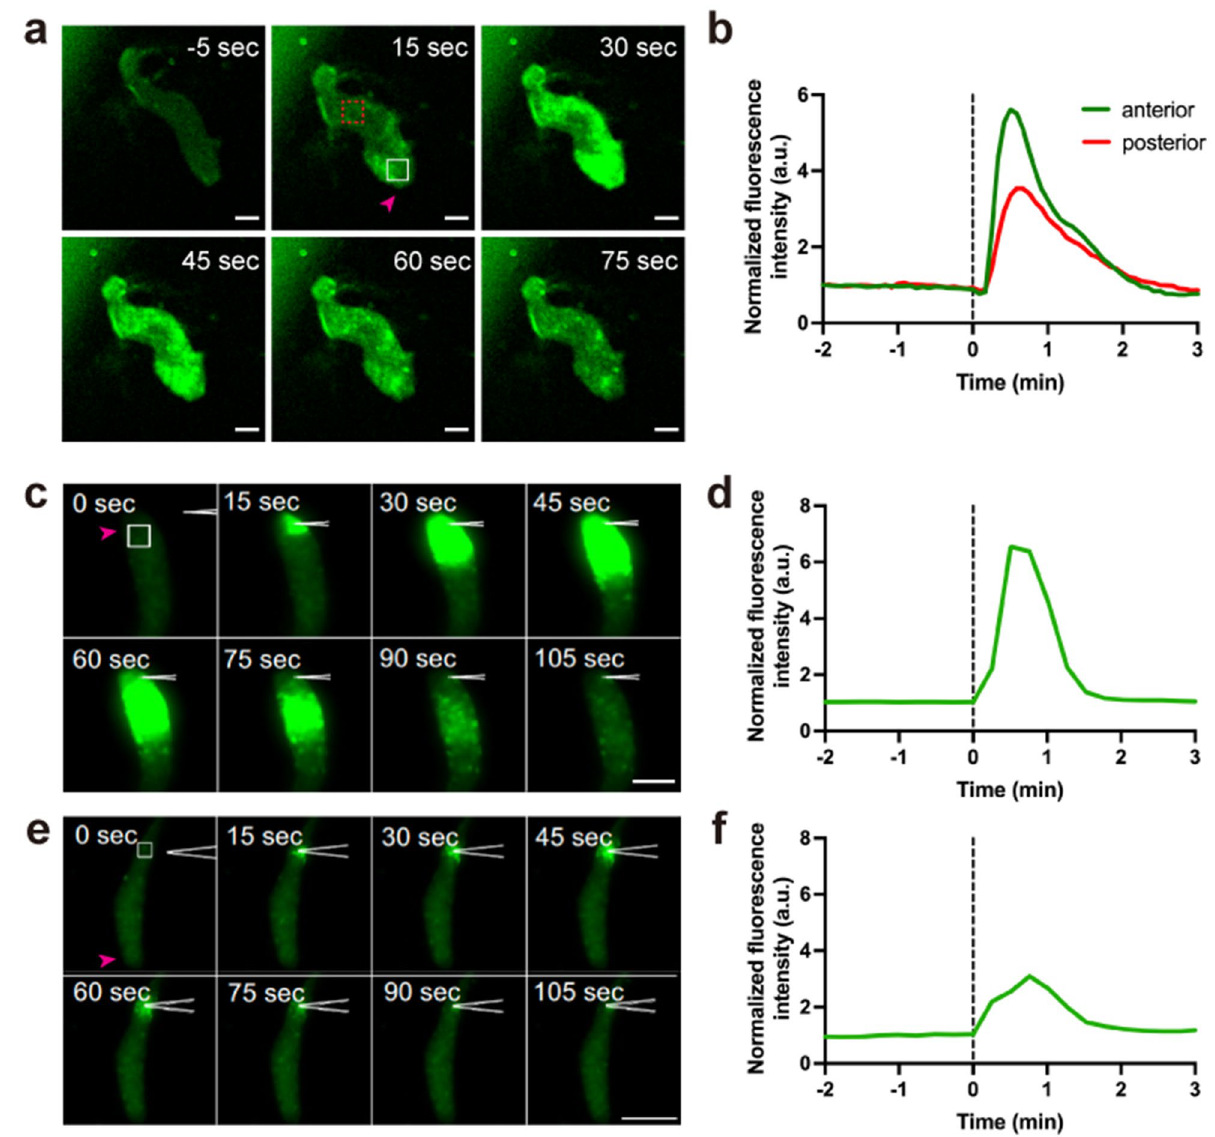
Figure 3. Intracellular Ca 2+ ([Ca 2+ ] i ) bursts in Dictyostelium slugs induced by mechanical stimulation. ( a ) Representative fluorescence micrographs of a slug expressing GCaMP6s, mechanically stimulated with a plastic rod. Scale bar, 50 µm. ( b ) Time course of mean fluorescence intensity of GCaMP6s in ROIs in the anterior (white square) and posterior (red dashed square) regions in ( a ). ( c , e ) [Ca 2+ ] i bursts at the tip ( c ) or posterior ( e ) of a slug expressing GCaMP6s after mechanical stimulation by pricking with a micropipette. Fluorescence micrographs of slugs expressing GCaMP6s are shown. Anterior part of the slug faces the top ( c ) or bottom ( e ). Scale bar, ( c ), 50 and ( e ), 100 µm. ( d , f ) Time course of mean fluorescence intensity of GCaMP6s in the 25 µm 2 region indicated with the white boxes in ( c ) and ( e ), respectively. Magenta arrowheads in ( a ), ( c ), and ( e ) indicate the anteriors of slugs. Black dashed lines in ( b ), ( d ), and ( f ) indicate the time point of mechanical